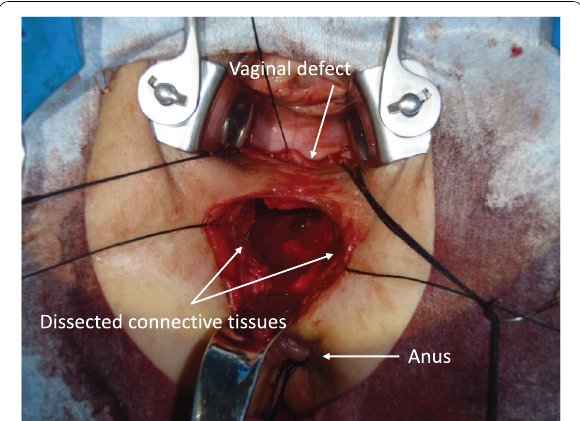
Fig. 6b. The operation lasted for 691 min, and the esti- mated blood loss was 795 g.